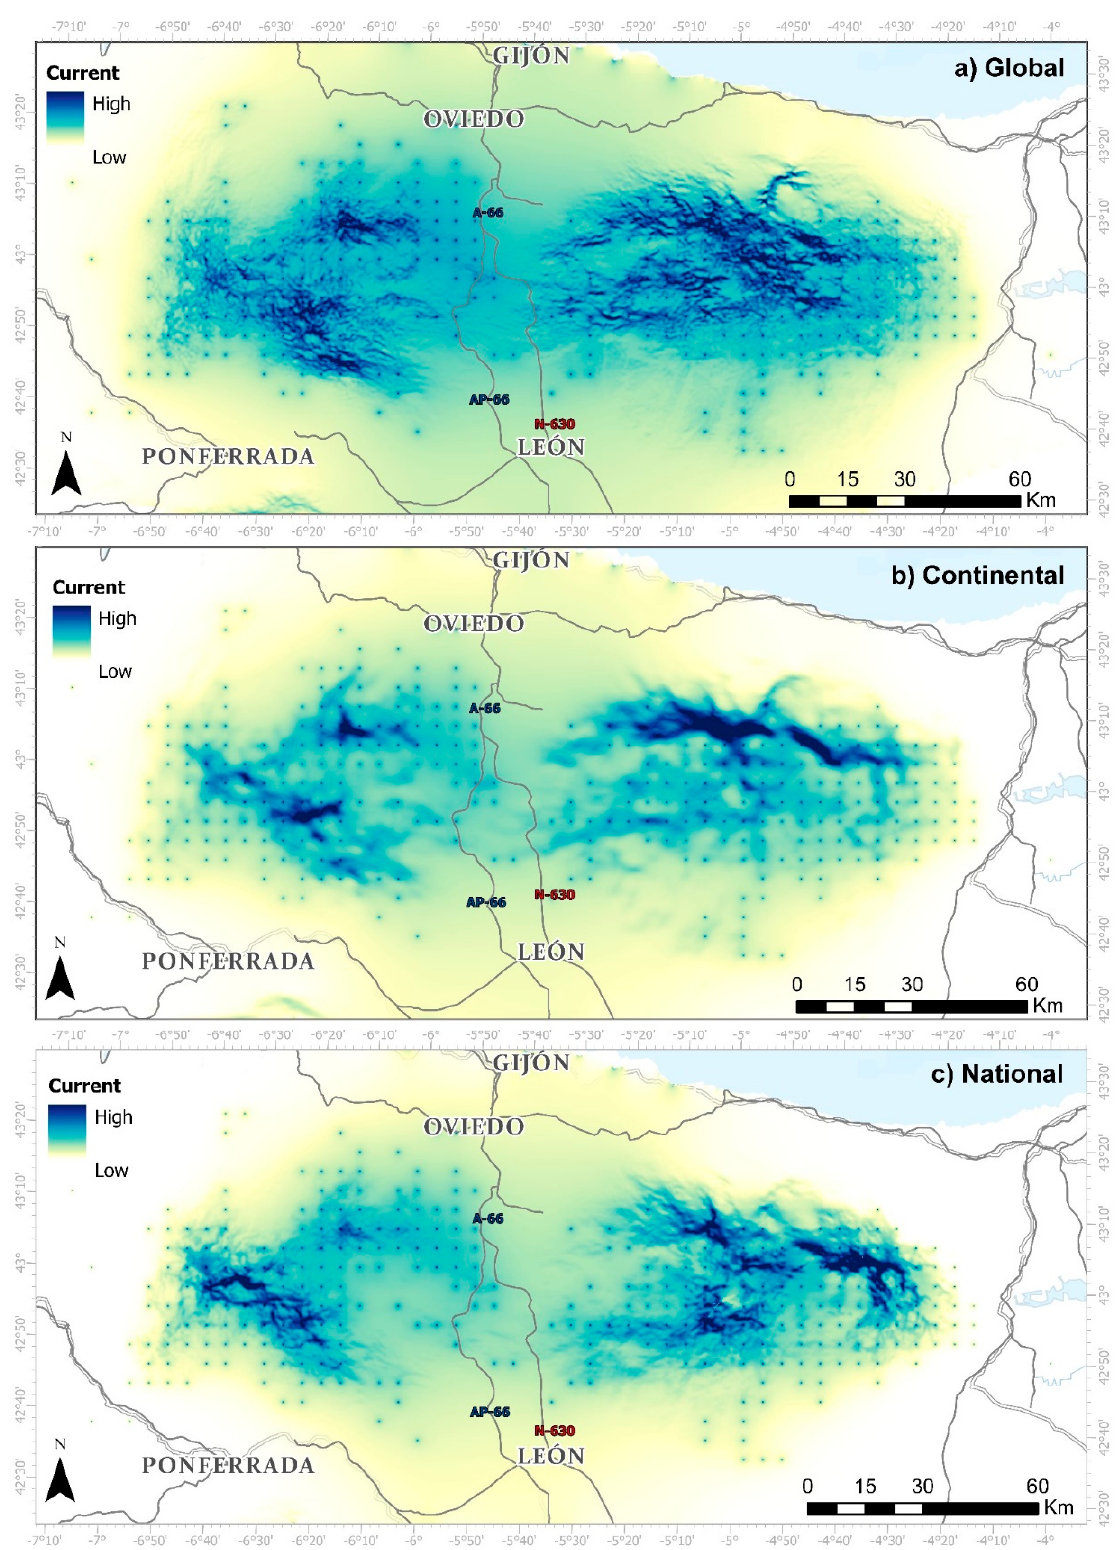
Figure 4. Current maps based on circuit theory methodology for the three resistance surfaces: ( a ) global model, ( b ) conti- nental model and ( c ) national model (see Figure A5 in Appendix B for the current map of the genetic model).